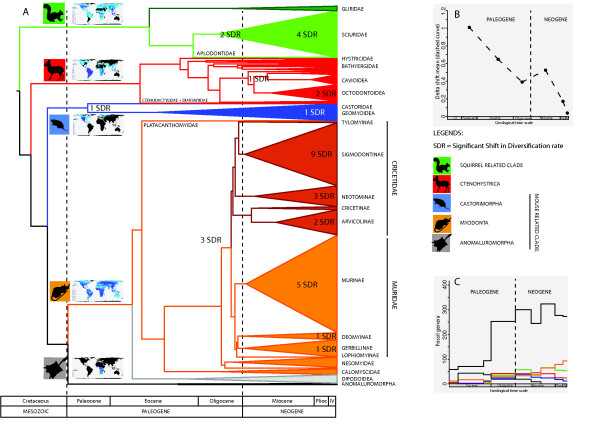
Diversification of rodents through time. Left part (A): Simplified family-level phylogenetic dated tree of rodents. Stratigraphic scale is in the lower part. Significant shifts in diversification rate (SDR) are indicated (see also Table 1 and Additional file 2: Figure S2, Additional file 3: Figure S3, Additional file 4: Figure S4, Additional file 5: Figure S5, Additional file 6: Figure S6, Additional file 7: Figure S7, Additional file 8: Figure S8, Additional file 9: Figure S9, Additional file 10: Figure S10, Additional file 11: Figure S11, Additional file 12: Figure S12 to Additional file 13: Figure S13). Upper right part (B): Variation through each epoch bin of the mean of absolute nodal Δshift statistics values calculated from the overall 2,263-taxon topology. Lower right part (C): Histogram of the number of rodents genera through Tertiary (McKenna and Bell, 1997). This illustrates the evolution of genus diversity for all rodents (black), extinct stem rodents (darkgreen), Muroidea+Anomaluroidea (orange), Castorimorpha (blue), Sciuroidea (green) and Ctenohystrica (red).